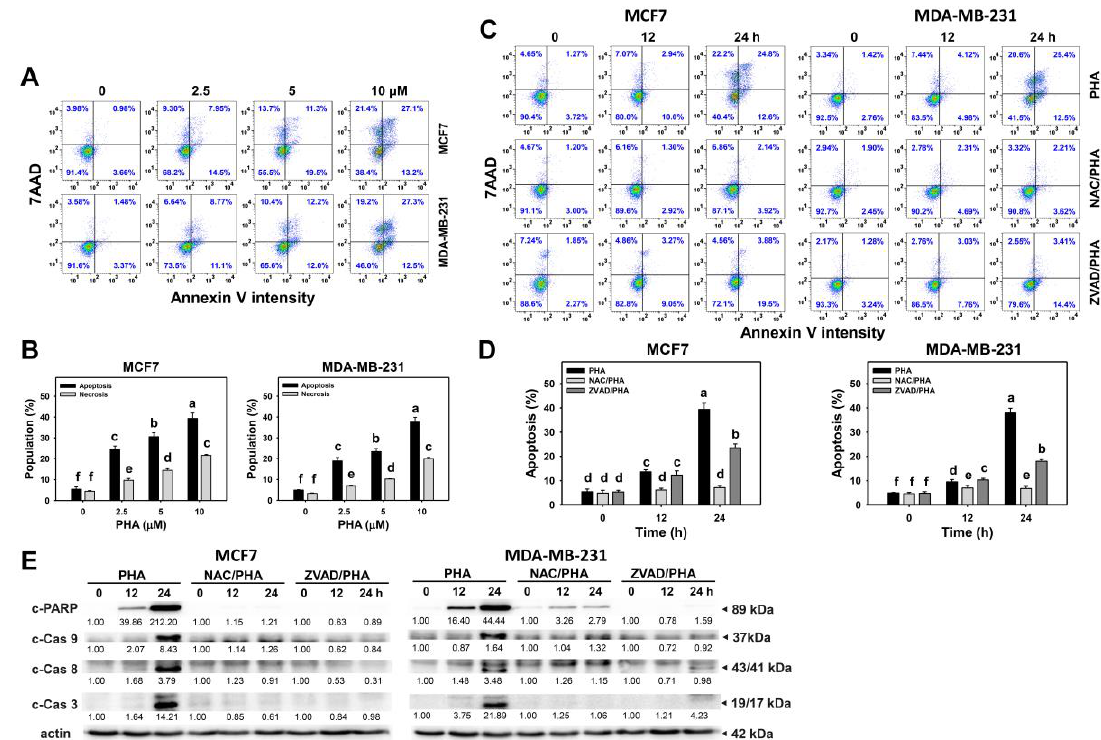
Figure 3. PHA triggers apoptosis and activates caspases in breast cancer cells. ( A , B ) Annexin V/7AAD patterns and statistical analysis for concentration responses to PHA. Cells were treated with PHA (0 (0.05% DMSO as control), 2.5, 5, and 10 μM) for 24 h. 7AAD (+/−)/annexin V (+) (%) ratio is regarded as the apoptosis (%), and 7AAD (+)/annexin V (−) (%) ratio is regarded as the necrosis (%) [28,29]. ( C , D ) Pattern and statistical analysis for NAC or ZVAD pretreatment responses in annexin V changes in PHA-post-treated breast cancer cells. Following pretreatment with either NAC (10 mM for 1 h) or ZVAD (100 μM for 2 h), cells were post-treated with 0 (0.05% DMSO as control) and 10 μM PHA for 0, 12, and 24 h, i.e., NAC/PHA or ZVAD/PHA. Data, means ± SDs ( n = 3 independent experiments). Experiments without the same top-labeled letters indicate significant changes based on multiple comparisons ( p < 0.05 to 0.0001). ( E ) Apoptosis-signaling expression of PHA-treated breast cancer cells. Cleaved PARP (c-PARP) and cleaved caspase 3, 8, and 9 (c-Cas 3, 8, and 9) expression is compared with reference to β -actin